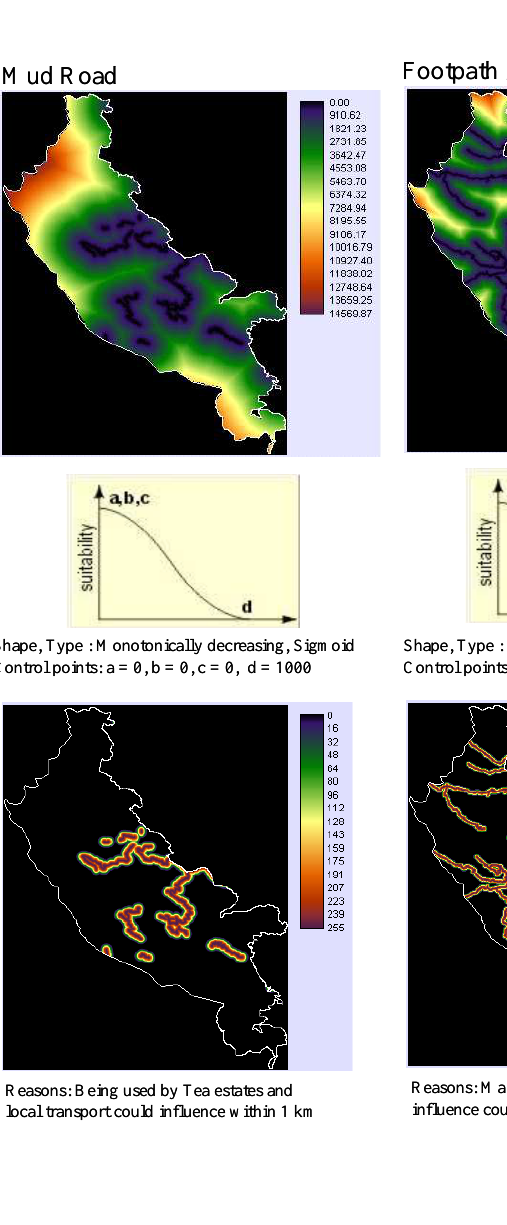
Figure 5. (d) List of potential spatial drivers (mud road, footpath and park boundary) generated using multi-criteria decision support to generate suitability image for the evergreen forest change modelling of KMTR, South Western Ghats, Tamil Nadu,